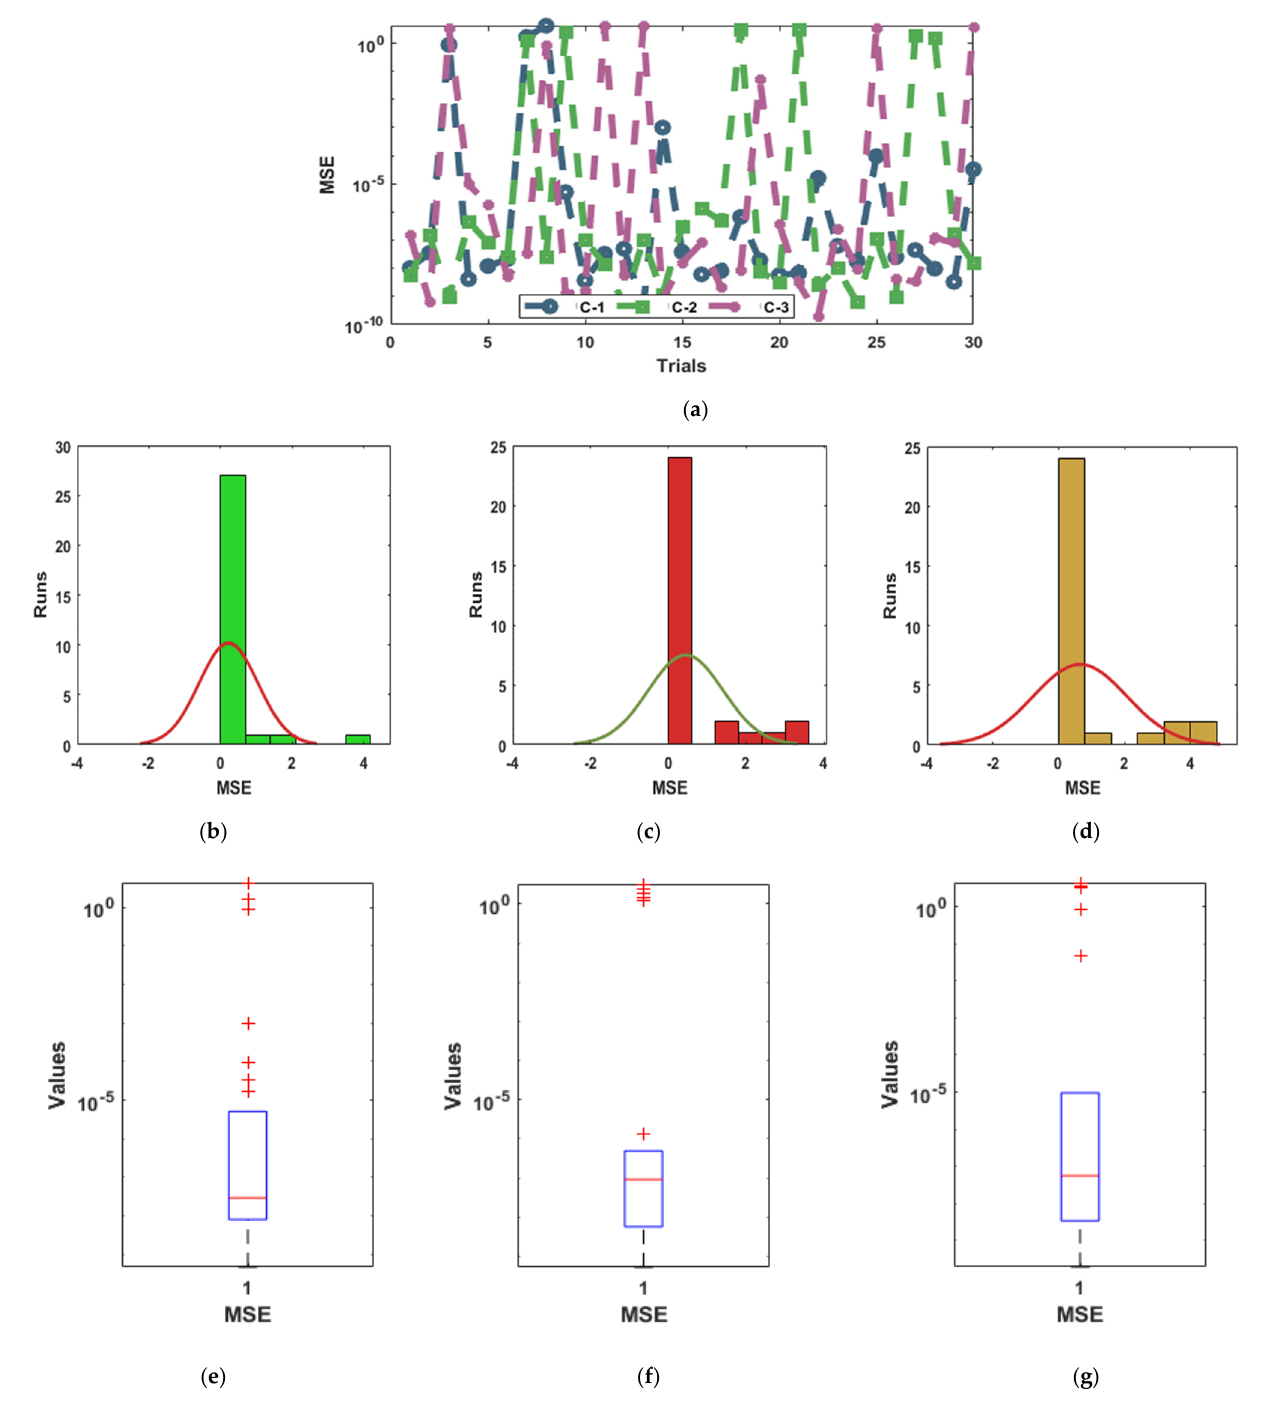
Figure 6. Performances through the statistical measures for the MSE values based on the NSPM-SK. ( a ) Performances of the MSE for case 1 to 3. (b) Hist of C-1. ( c ) Hist of C-2. ( d ) Hist of C-3. ( e ) BPs of C-1. ( f ) BPs of C-2. ( g ) BPs of C-3.